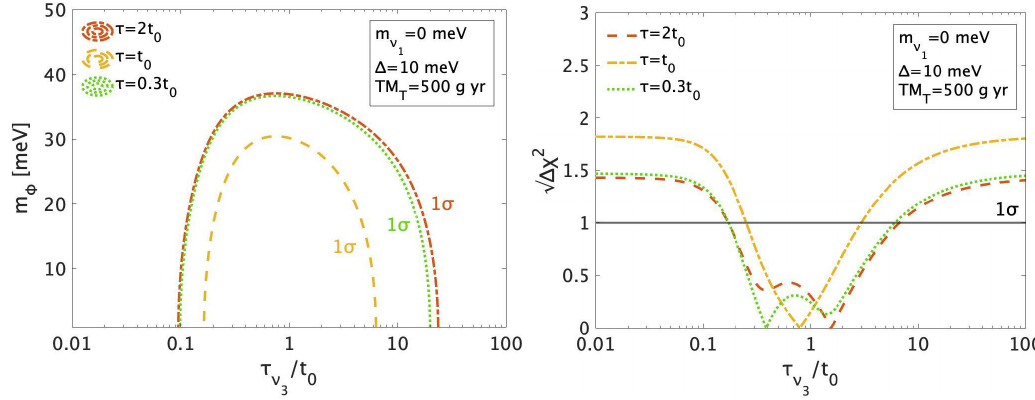
, m ) for φ 3 = 500 g yr. T . A fiducial value of ( ˆ τ , ˆ m ) is ν 3 ν 3 φ 0) (green dotted). 0 ,